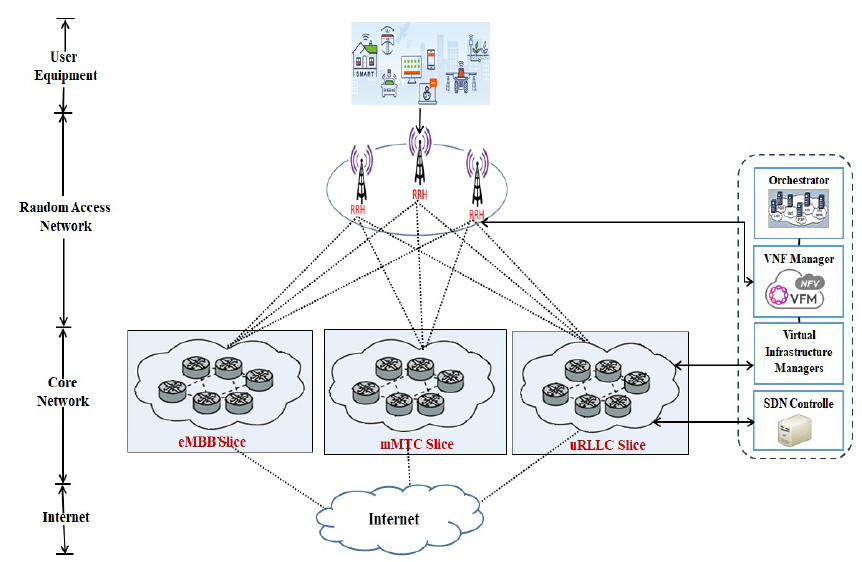
Figure 1. Architecture of 5G mobile network with